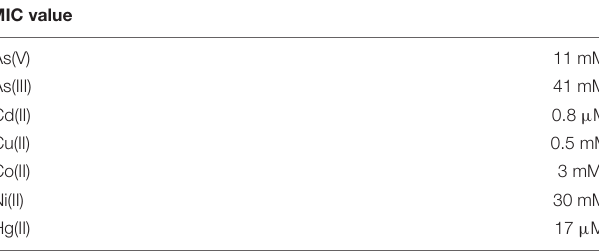
TABLE 6 | Alicyclobacillus mali FL18 tolerance to heavy metal